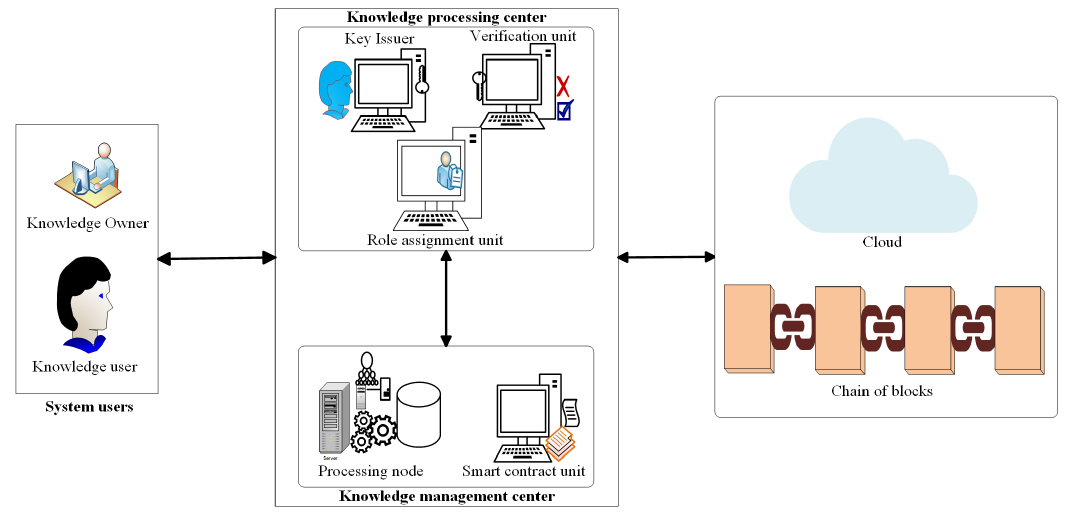
Figure 1. System architecture.